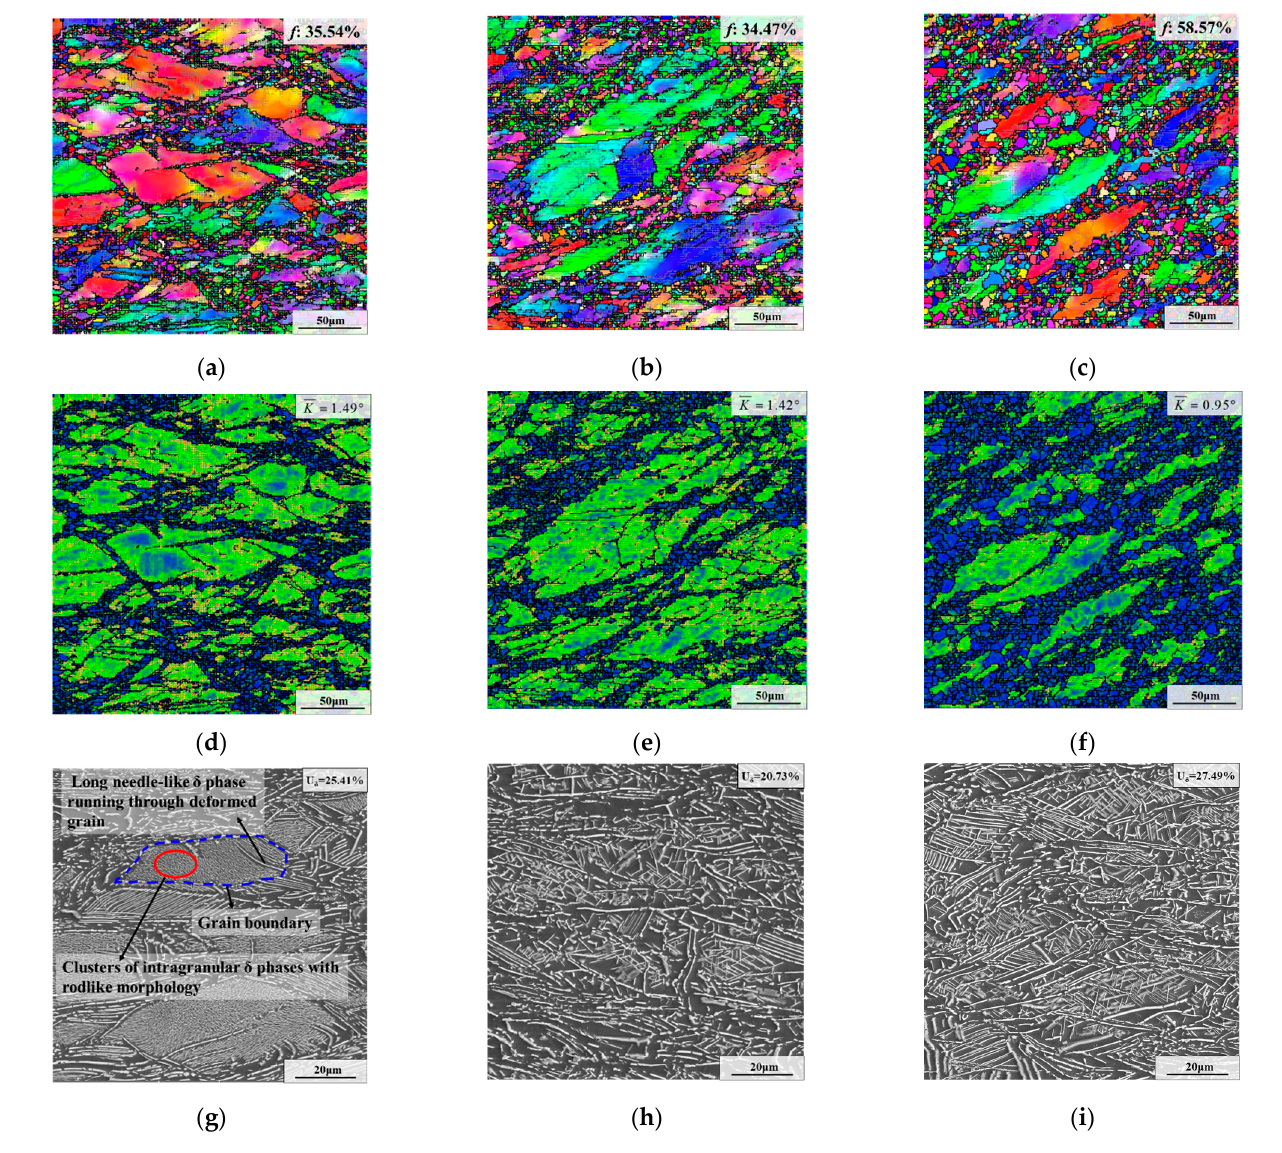
Figure 7. Microstructures after the first annealing stage with different deformation temperatures of: ( a , d , g ) 950 °C; ( b , e , h ) 980 °C; ( c , f , i ) 1010 °C. (The strain rate is 0.1 s − 1 , and the true strain is 0.69). ( a , d , g ) 950 ◦ C; ( b , e , h ) 980 ◦ C; ( c , f , i ) 1010 ◦ C. (The strain rate is 0.1 s − 1 , and the true strain is